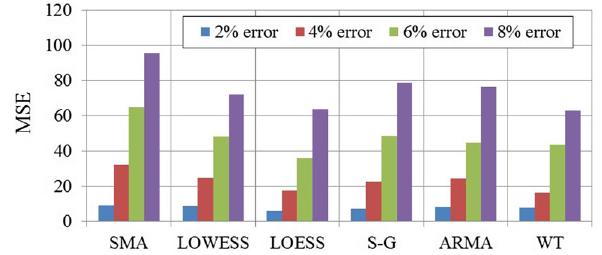
Fig. 12 MSE related to noises removal from pressure transient data by different denoising data for a 2%, b 4%, c 6%, and d 8% artificial noise addition